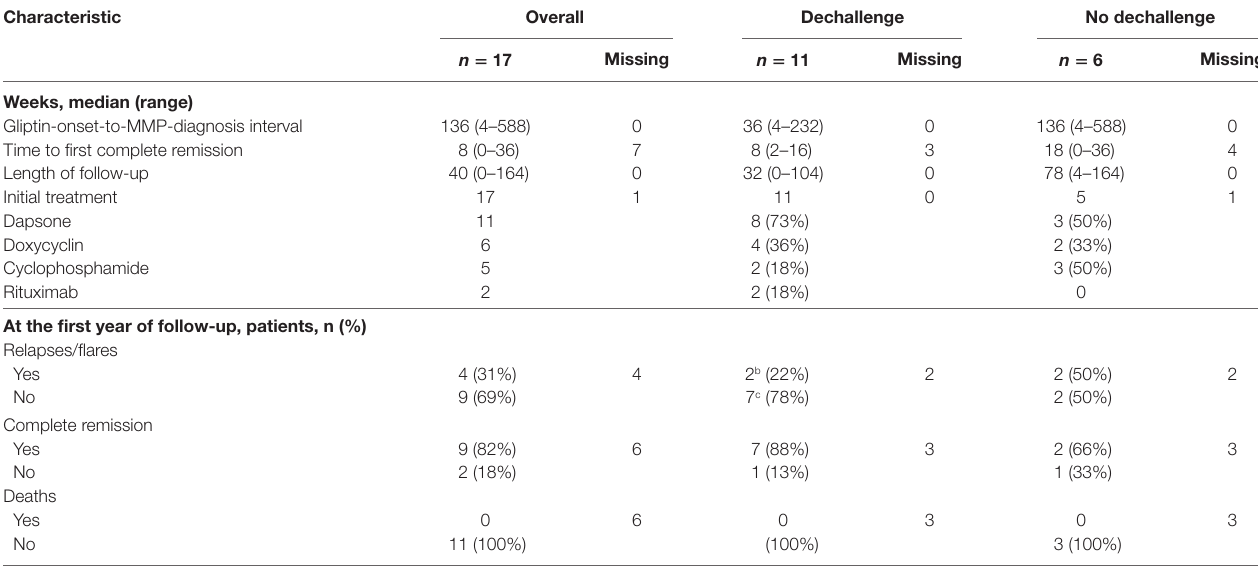
Table 3 | Evolutive characteristics of the suggestive-or-compatible challenge MMP patients who discontinued gliptin (dechallenge) vs. those who continued it (no dechallenge). a characteristic Overall